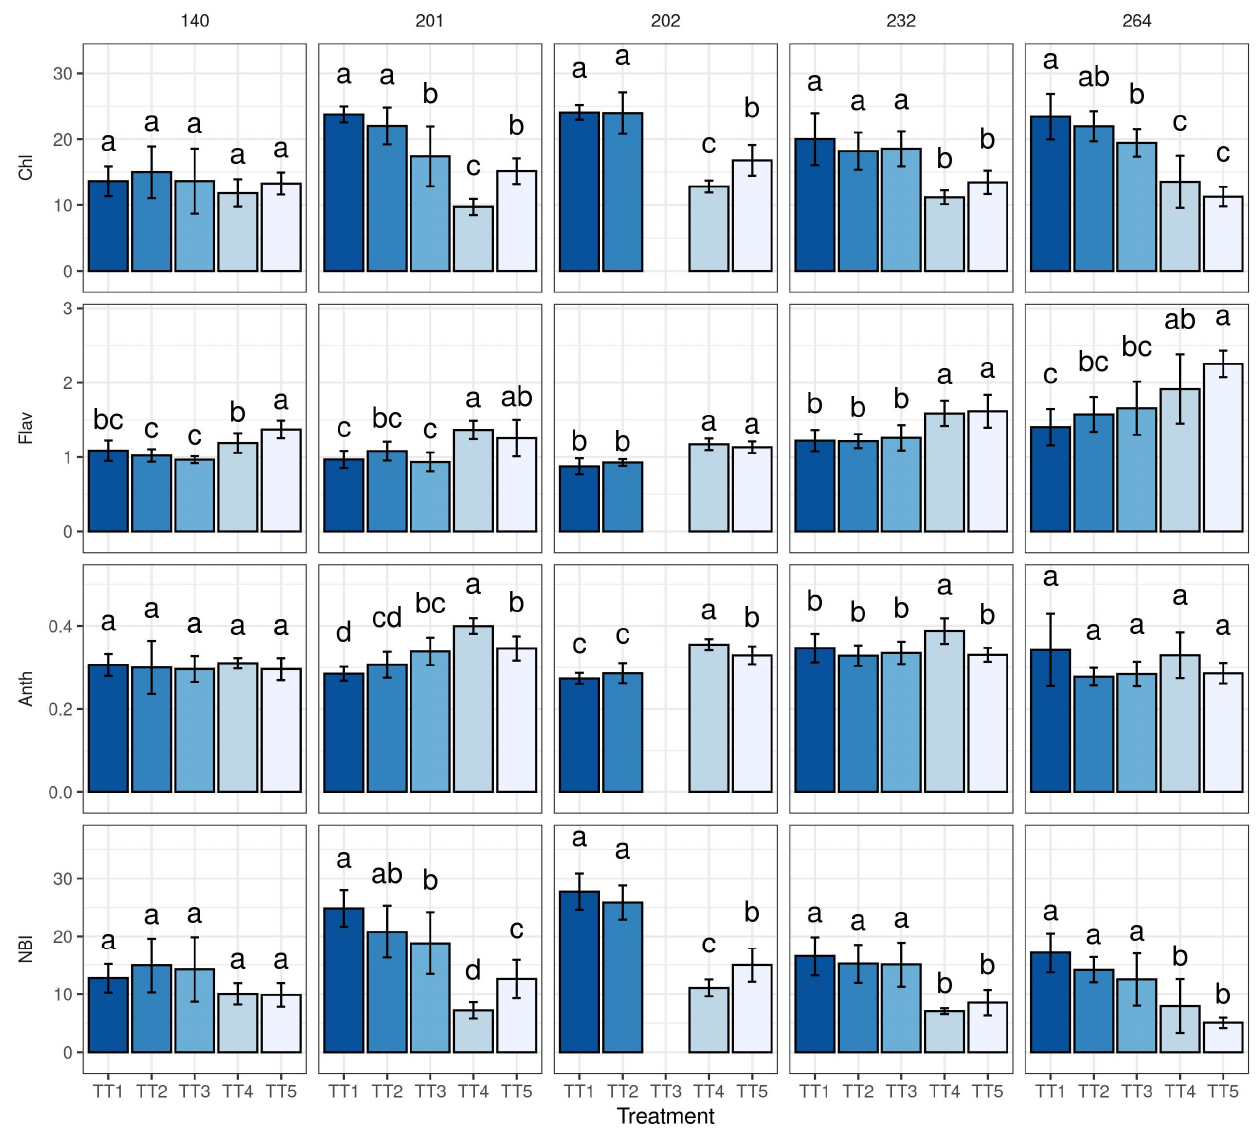
Figure 6. Barplot of hazelnut Tonda Gentile mean chlorophyll (CHL), flavonoids (FLA) and anthocyanins (ANTH) index, and nitrogen balance index (NBI) at depending on DOYs and the substrate. TT1 = Commercial Peat (P) 90% + Compost B(CB) 10%; TT2 = P 80% + CB 20%; TT3 = P 60% + CB 40%; TT4 = Commercial Peat (P) 100%; TT5 = P Commercial Peat 100% + Osmocote. Error bars indicate standard deviations around the mean. Different letters indicate statistically significant differences after ANOVA and Duncan post-hoc test at p -value < 0.05.